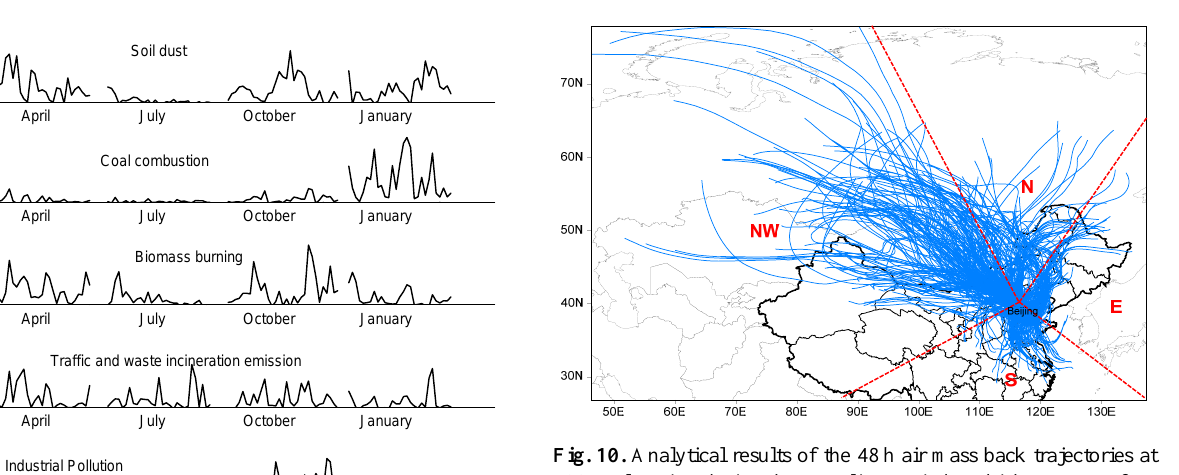
Figure 10 Fig. 10. Analytical results of the 48h air mass back trajectories at 100m elevation during the sampling periods, which were run four times per day. Four regions were defined based on the trajectory clustering results, i.e., NW, N, E, and S